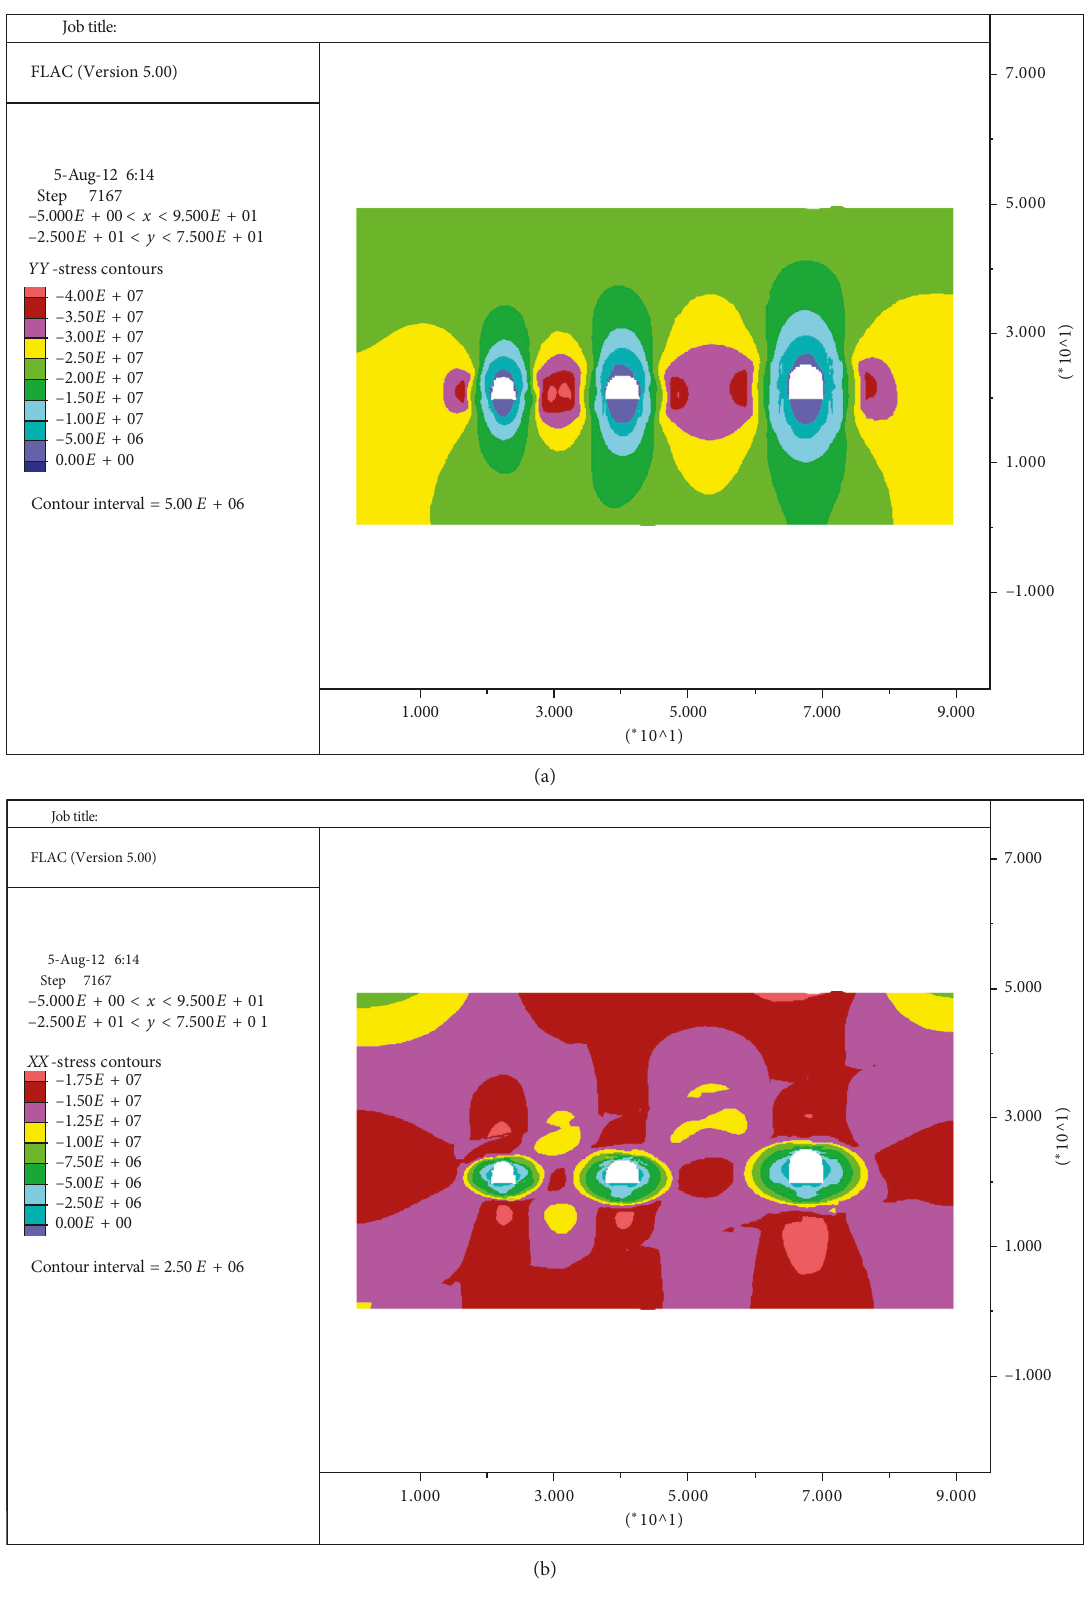
Figure 16: Surrounding rock stress distribution of each repaired chamber. (a) Vertical stress field. (b) Horizontal stress